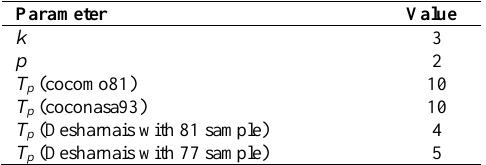
Table 4. Values of method parameters in this work.